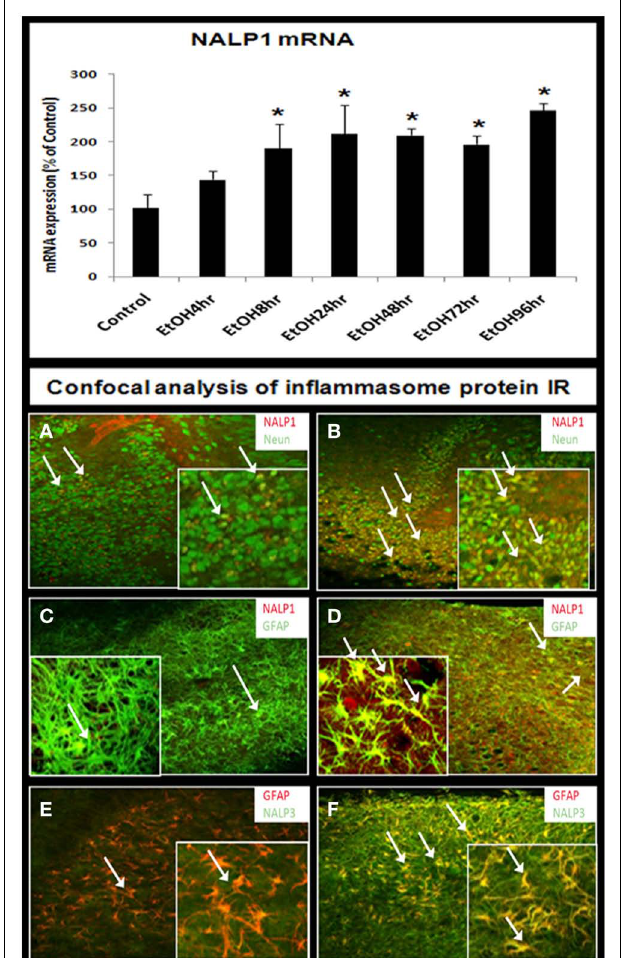
FIGURE 7 | Ethanol induction of inflammasomes in HEC slices. RT-PCR analysis shows that ethanol exposure persistently up-regulates inflammasome NALP1 mRNA (bar graph, top). Representative confocal images are shown for cellular expression of inflammasome NALP1 and NALP3. (A,B) Double fluorescent immunostaining with NALP1 (red) and neuronal cell marker NeuN (green) show ethanol induction of NALP1 in DG granule neurons (arrows) [ (A) control; (B) ethanol, original magnification 20 × ; insert-80 × ]. (C,D) Double fluorescent immunostaining with NALP1 (red) and astrocyte neuronal marker GFAP (green) show ethanol induced strong induction of NALP1 in astrocytes (yellow, arrows) [ (C) control; (D) ethanol, original magnification 20 × ; insert-80 × ]. (E,F) Double fluorescent immunostaining with NALP3 (green) and astrocyte marker GFAP (red) show ethanol induction of inflammasome NALP3 in astrocytes (yellow, arrows) [ (E) control; (F) ethanol, original magnification 20 × ; insert-80 × ]. alcoholic brain was depicted ( Figure10I ). NALP1 was increased in alcoholicbrainsinhippocampalcellsthatco-localizedwithmature neuronal marker calbindin ( Figure 10J ) and in some GFAP + cells ( Figure 10K ) but rarely co-expressed in Iba-1 + microglia (data not shown). NALP3 was co-localized with NeuN + neu- ronal cells and Iba-1 + IR microglia in DG and CA region. The increased NALP3 IR in NeuN + neurons and Iba-1 +